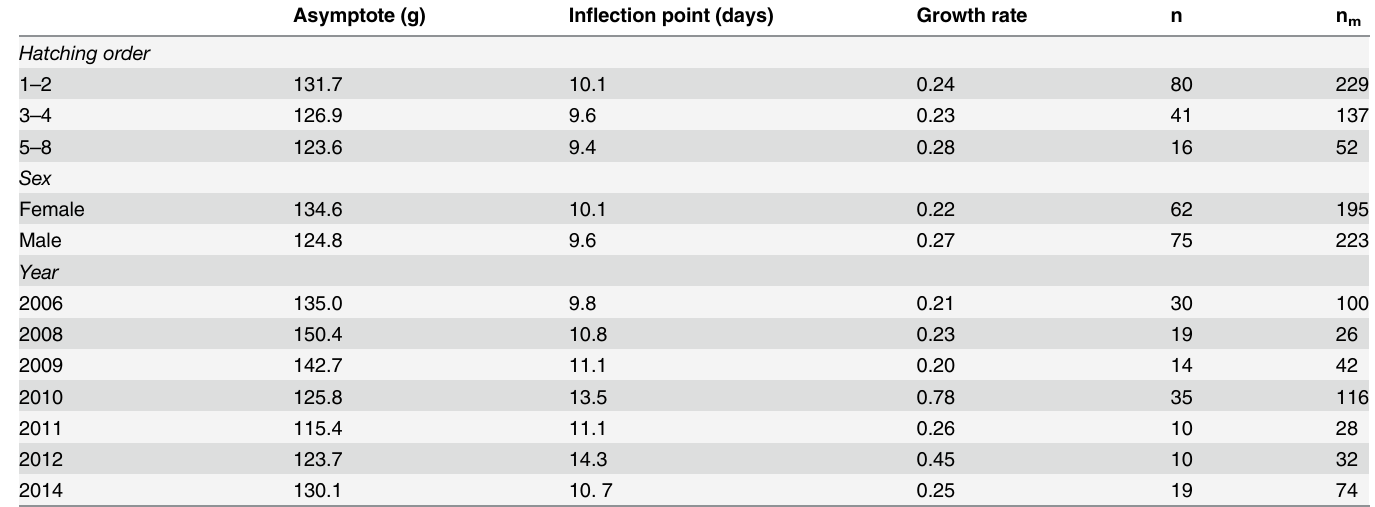
Table 3. Parameters of the growth curve for Tengmalm ’ s owl nestlings related to year, hatching order and the sex of nestlings. The asymptote (maximal body mass), inflection point and growth rate are shown (n = number of nestlings measured; n m = number of